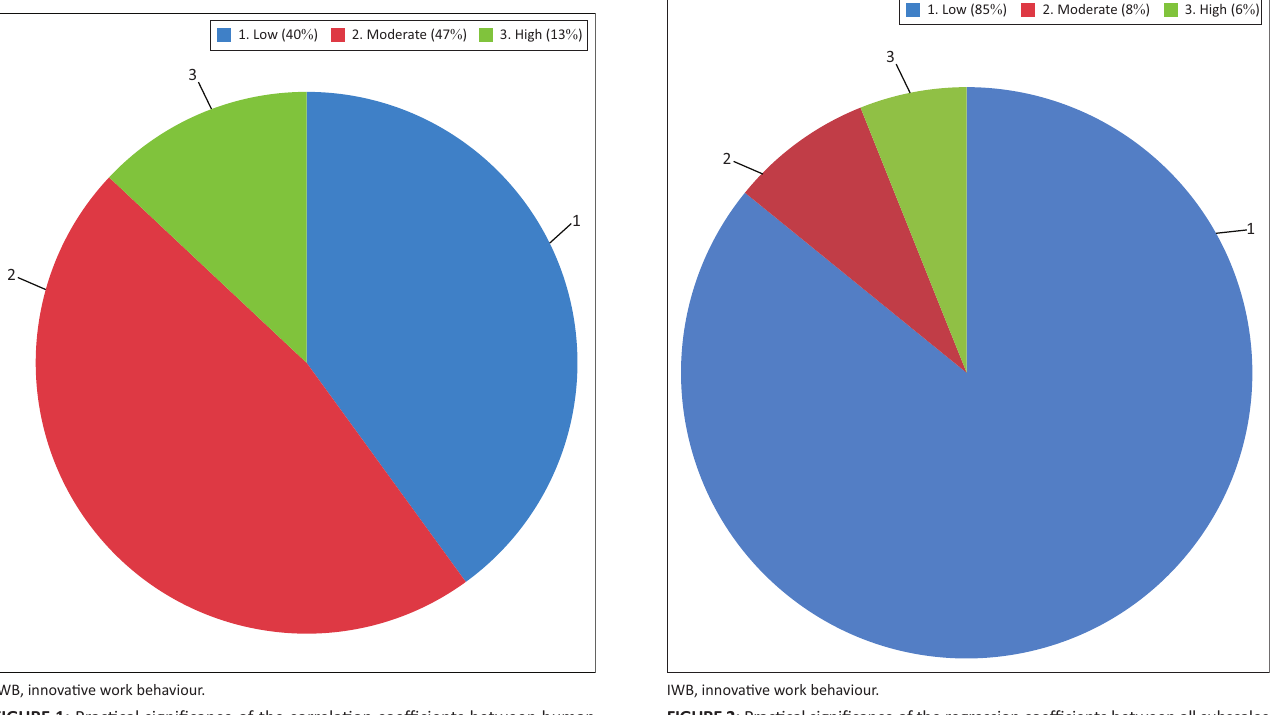
FIGURE 1: Practical significance of the correlation coefficients between human resource practices and innovation across organisations.